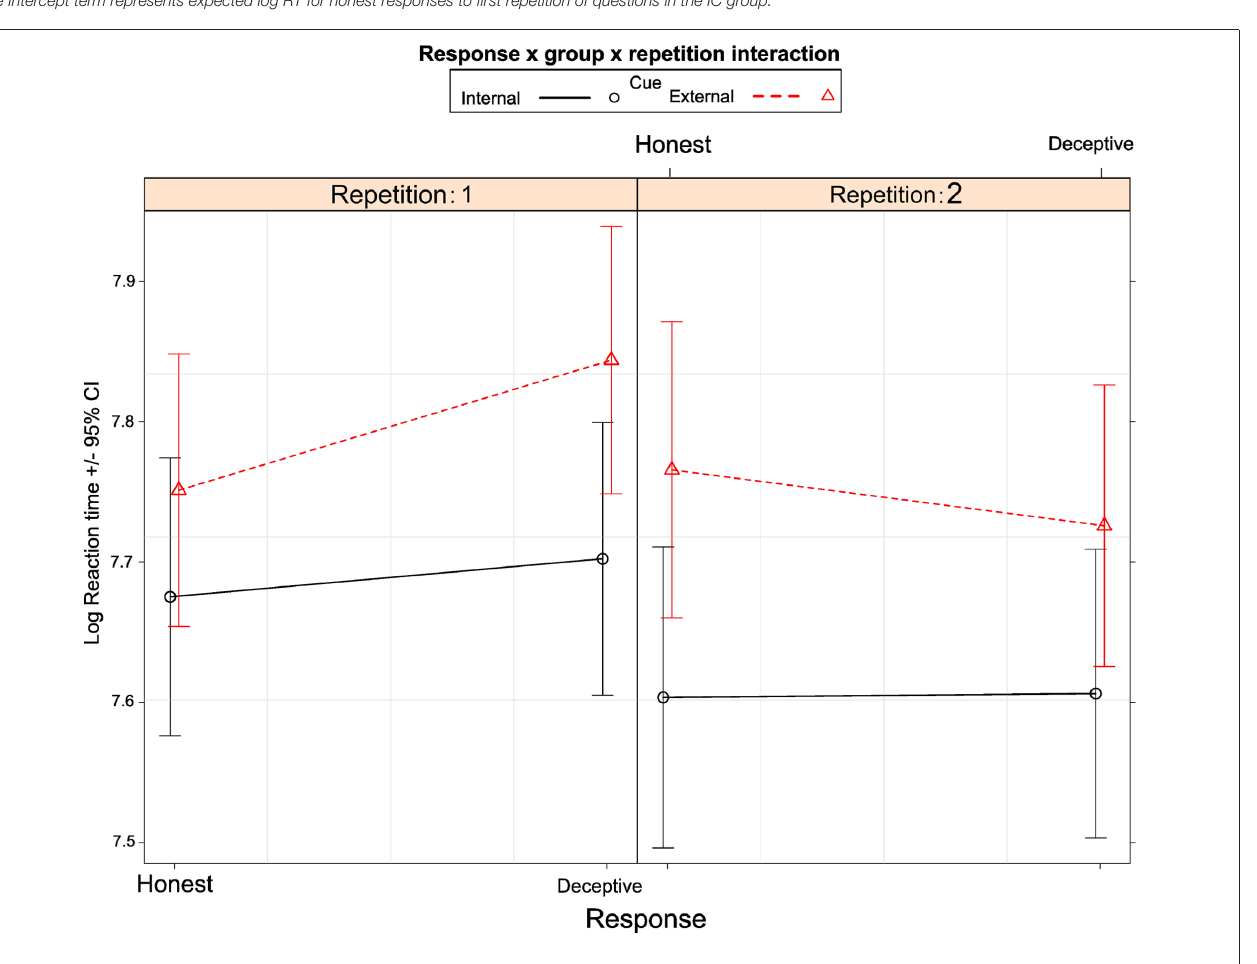
the externally cued group compared to the internally cued